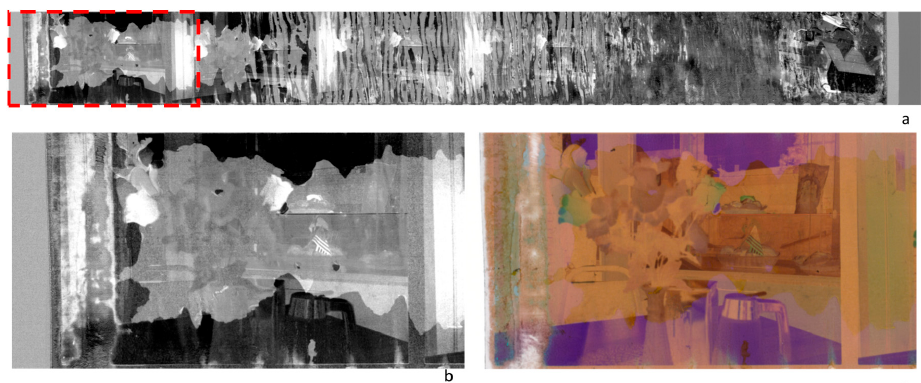
Figure 6. ( a ) The PC4 image obtained by the HSI data set acquired on the film-strip negative reported in Figure 4. ( b ) Detail of the first photogram in the PC4 image; ( c ) Detail of the first photogram in the sRGB image.